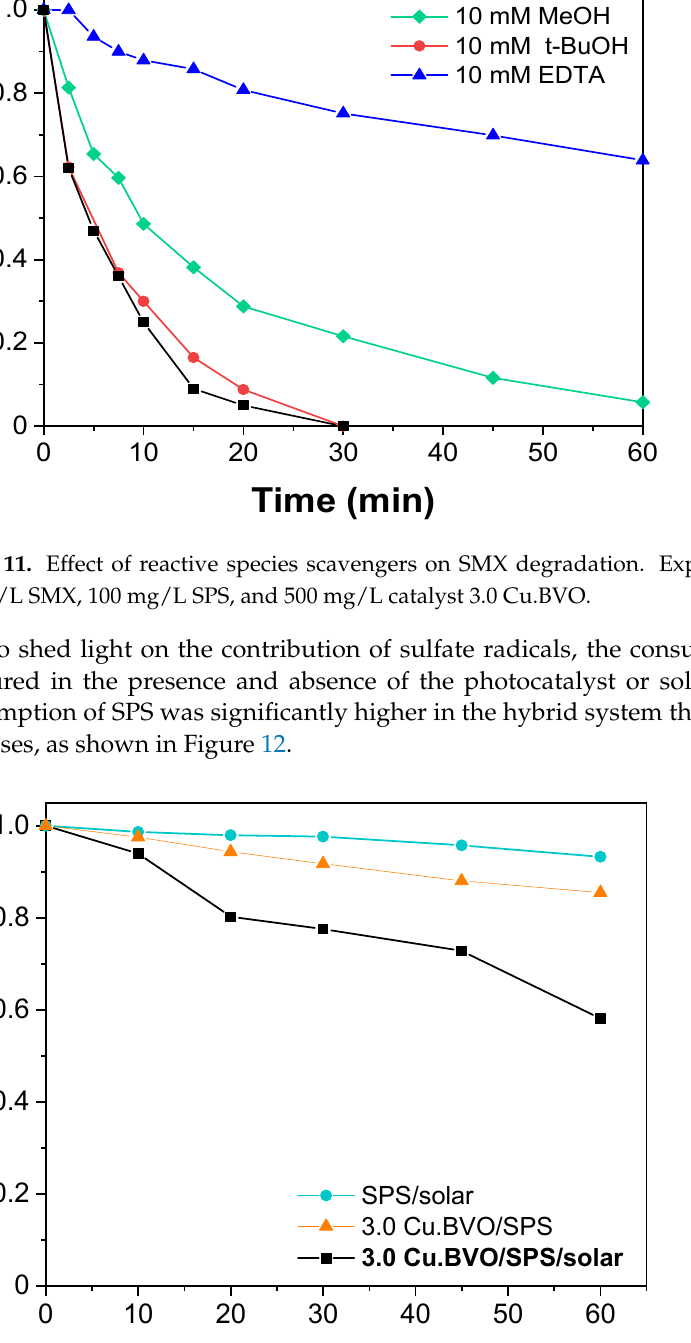
Figure 11. More specifically, EDTA was used to bind photogenerated holes, tert butanol (which reacts mainly with hydroxyl radicals), and methanol (which reacts at a similar rate with hydroxyl radicals and sulfate radicals). From Figure 11, it is evident that the presence of t-butanol does not cause a significant inhibition. In contrast, SMX degradation was hindered in the presence of methanol; the inhibition becomes significant when EDTA is present in the solution, which indicates the dominant role of photogenerated holes.